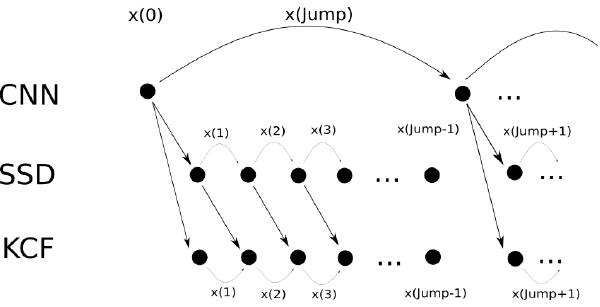
Figure 1. Execution diagram.